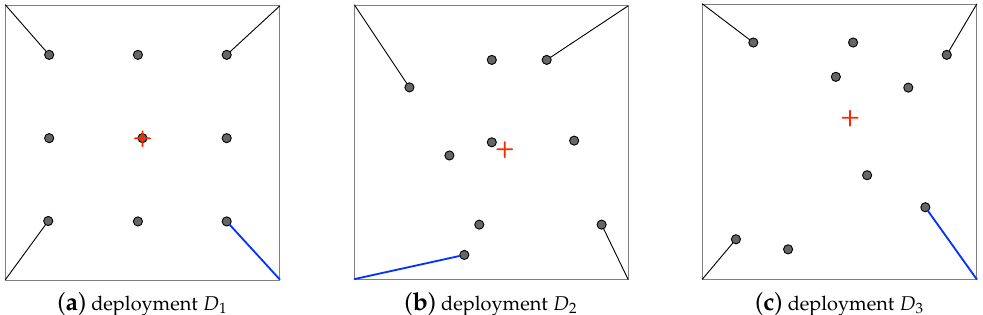
Figure 3. Comparison of three deployments of points in the coverage balance loss. In each deployment, the side length of the square region of interest (RoI) is 10, and the red cross represents the median position of all the nine points. The losses of coverage balance in the three sub-figures are (cid:96) ( D 1 ) = 2.04, (cid:96) ( D 2 ) = 2.23, and (cid:96) ( D 3 ) = 2.37.